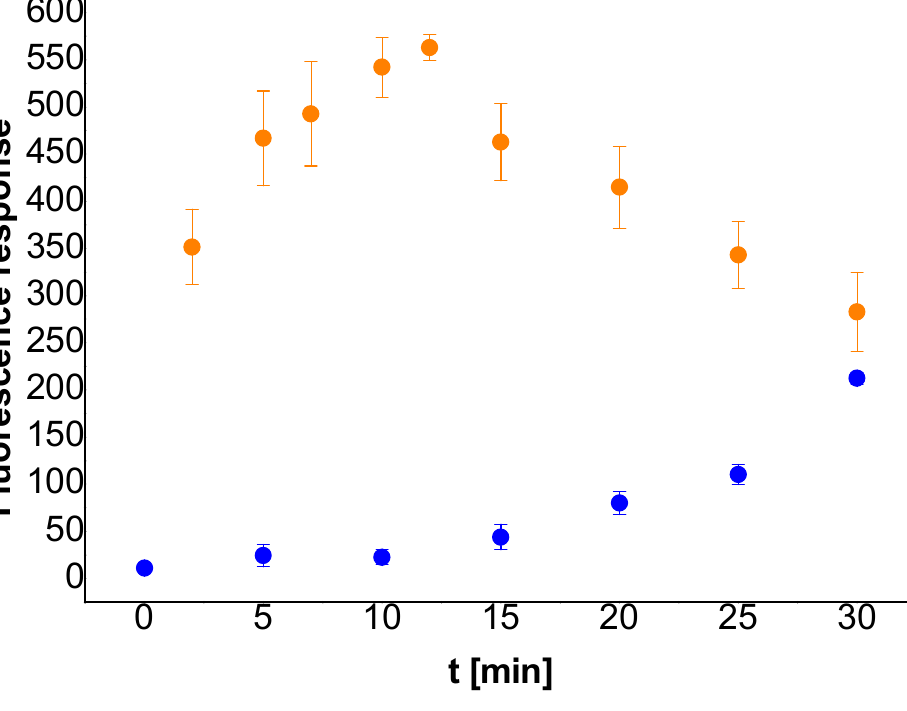
Figure 5. Time dependent fluorescence response of the dissolved released fragment from the ICT bound to Rink Amide PEGA resin in the presence (yellow dots) and absence (blue dots) of chy- motrypsin (250 µ g/mL). The probe (2.0–2.1 mg) was dispersed in Tris-HCl buffer (0.1 M; 1 mL). Fluorescence emission was measured at 595 nm after excitation at 554 nm. Detector voltage was set to 500 V.